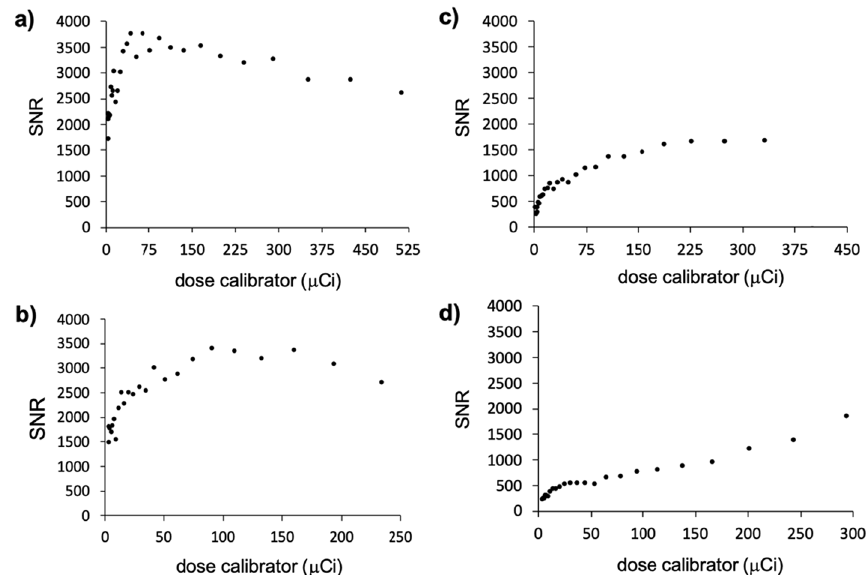
Fig. 2 PET SNR in the presence of the MRI instrument. A phantom with fluorine-18 ( a ) at 19.43 MBq (525 µCi) was imaged using a PET insert outside the MRI magnet, ( b ) at 8.88 MBq (240 µCi) was imaged using a PET insert inside the MRI magnet without an active MRI acquisition, ( c ) at 12.58 MBq (340 µCi) was imaged using a PET insert inside the MRI magnet while a RARE MRI pulse sequence was run, and ( d ) at 11.1 MBq (300 µCi) was imaged using a PET insert inside the MRI magnet while a FISP MRI pulse sequence was run. Each data point represents a PET image that was recorded every 30 min over a 12 h time period. An ROI was drawn over the tube and also over a background region in each image to calculate SNR